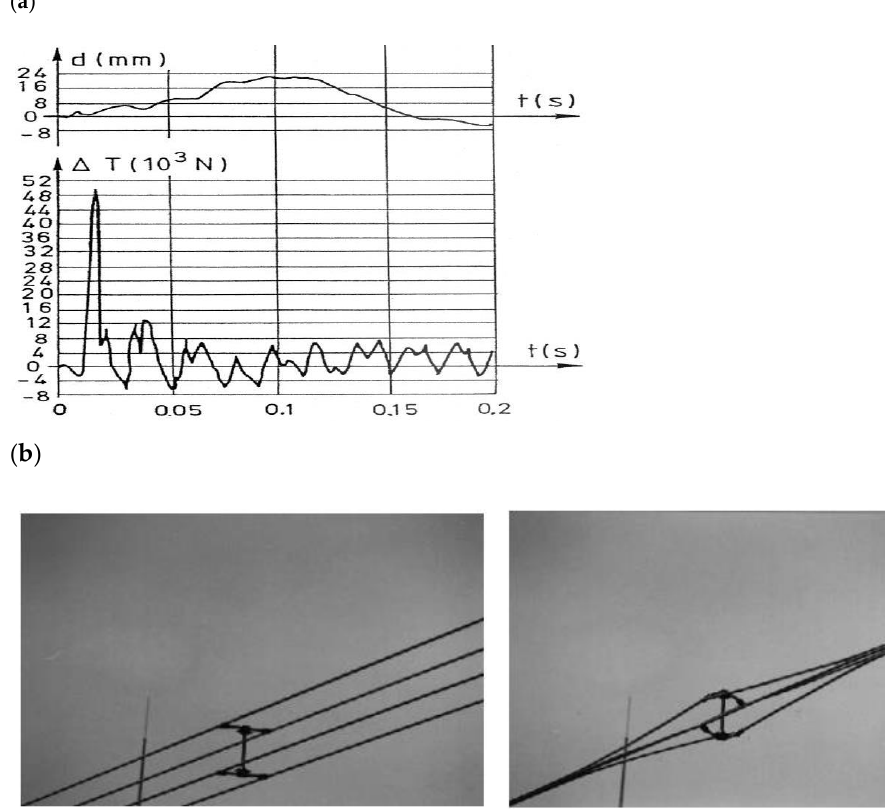
Figure 4. Example of the range of movement of one phase’s conductors during a short circuit [9].